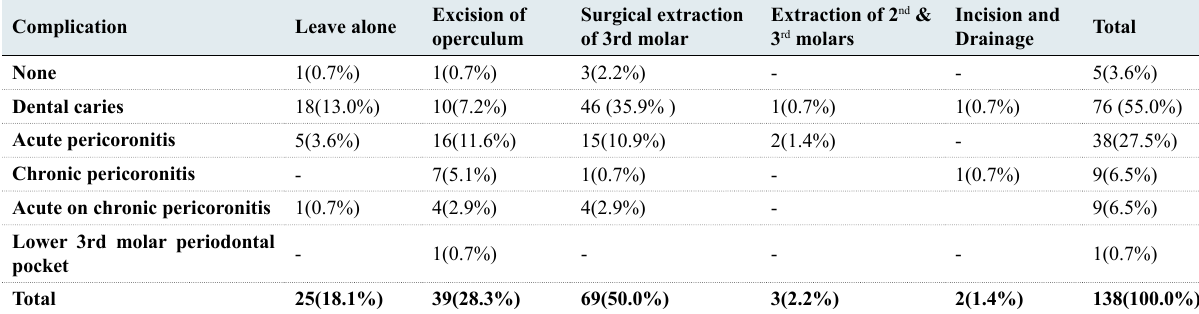
Excision of Surgical extraction Extraction of 2 nd & Incision and operculum of 3rd molar Drainage